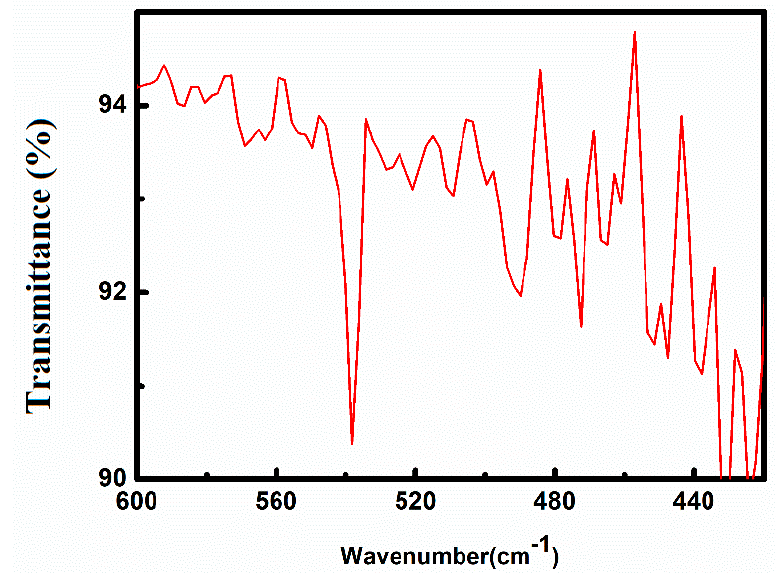
Figure 2. FTIR spectra of ZnO functionalized hydrogel grafted silk dressing.